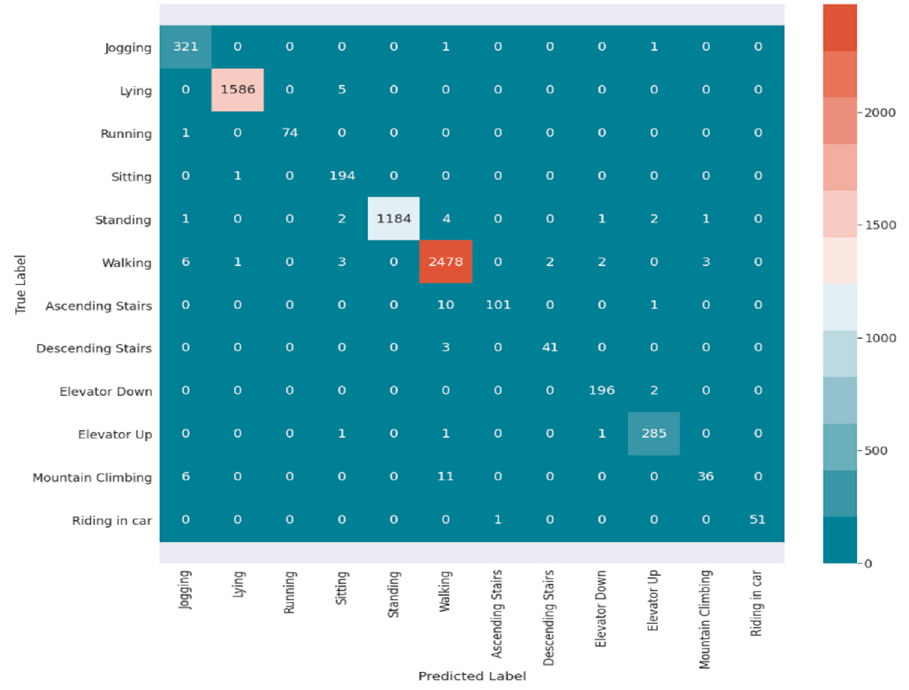
Figure 11. Confusion matrix for the noncontextual model.